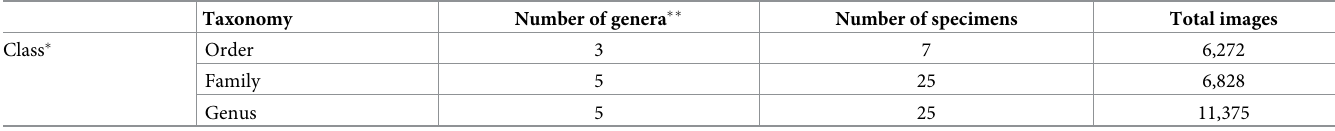
Table 2. Number of acquired images per taxonomic rank per class. Taxonomy